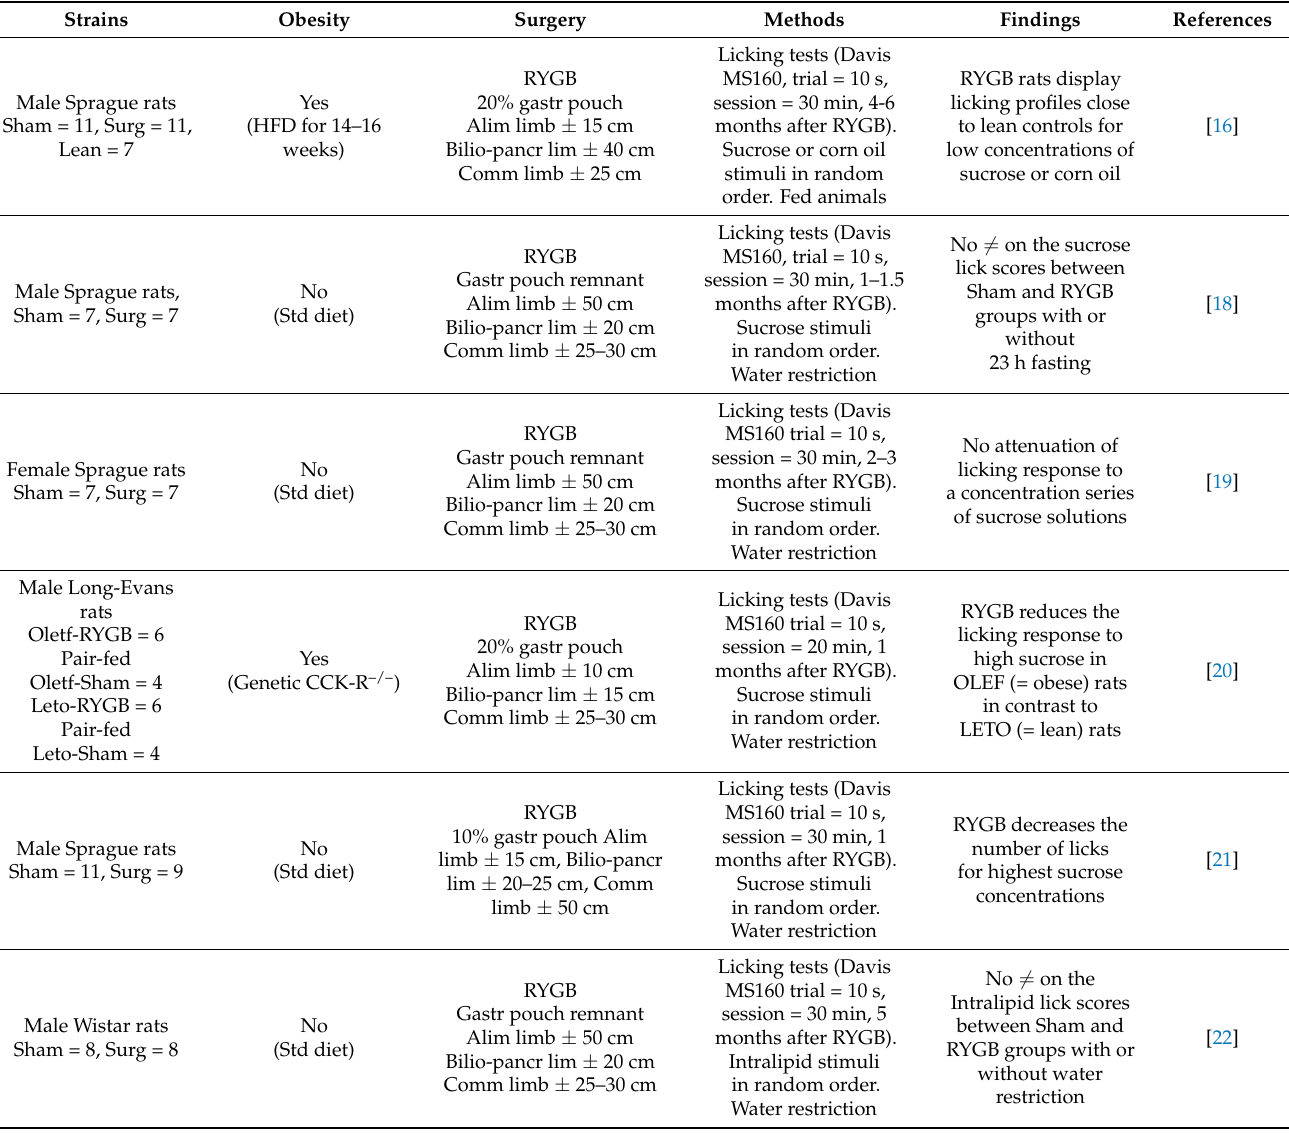
Table 1. Impact of RYGB on the taste-driven responses to sweet and fat stimuli in